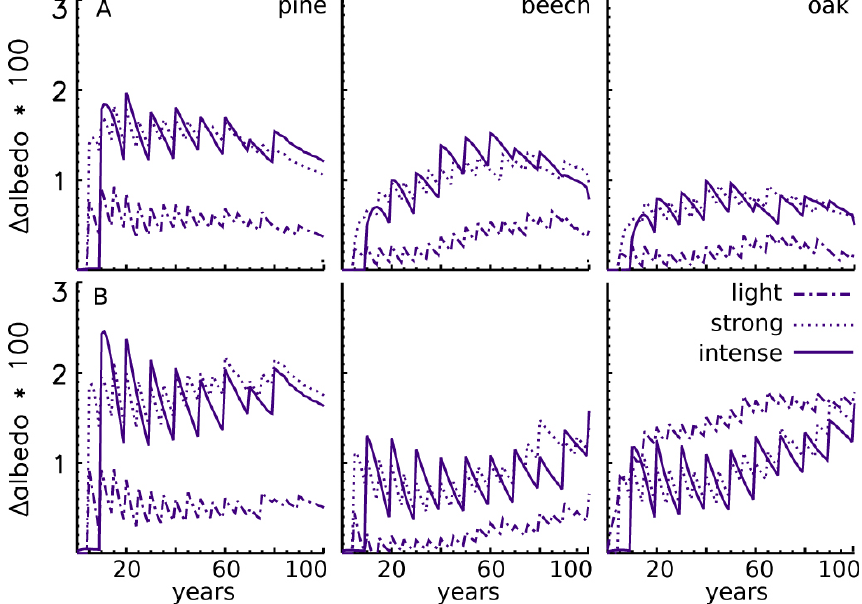
Fig. 6. Difference between shortwave albedo (June) of unmanaged forest and managed forest at 50 ◦ N (A) black-sky albedo and (B) white-sky albedo. Note that the albedo-difference values are multiplied by 100 for better